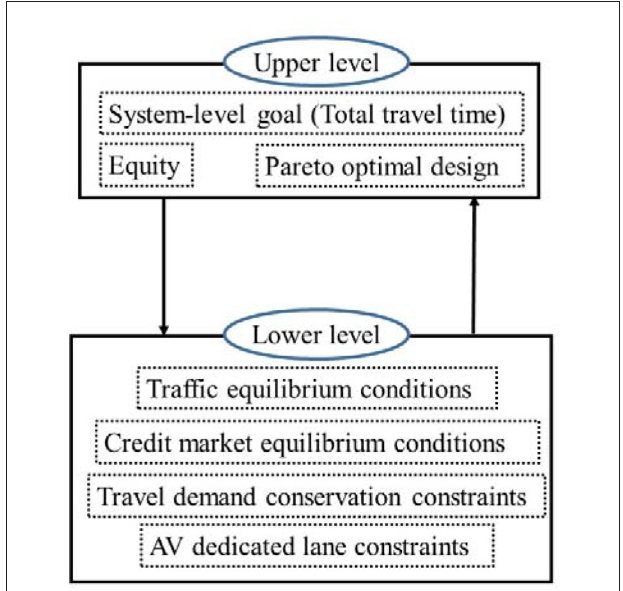
FIGURE 2 | Structure of bi-level model for TLMAV design.